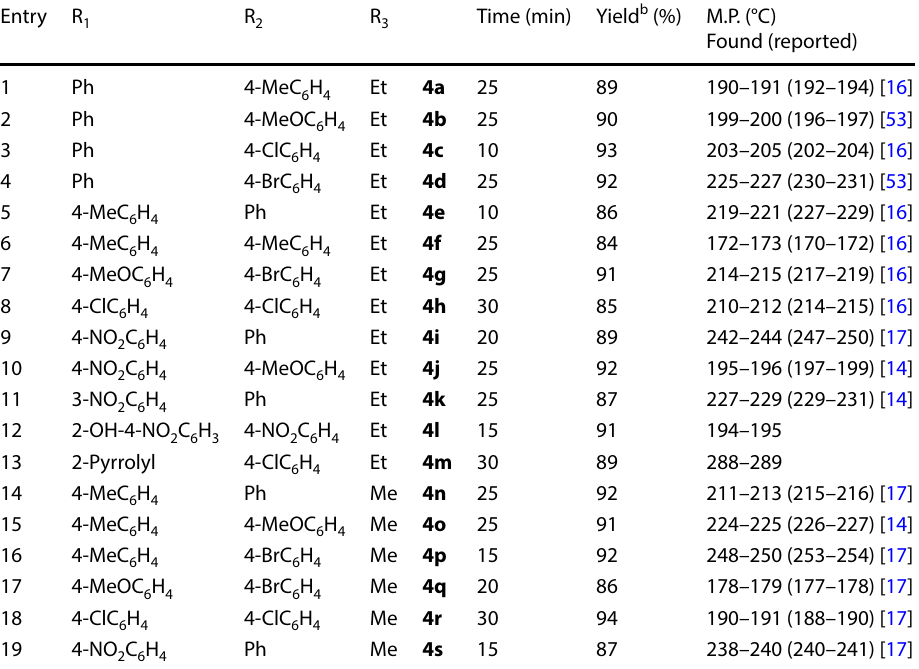
Table 2 Ultrasound-assisted synthesis of multi-substituted THP-3-carboxylates in aqueous media